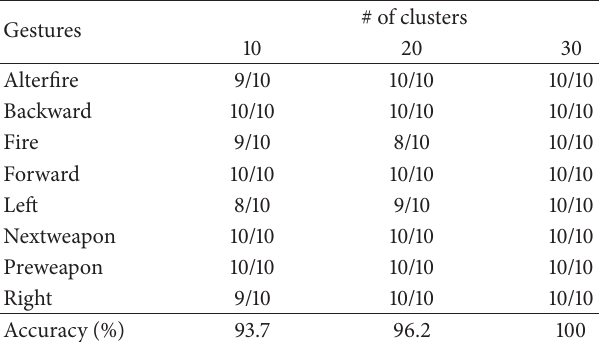
Table 1: Experimental result for Kyonggi